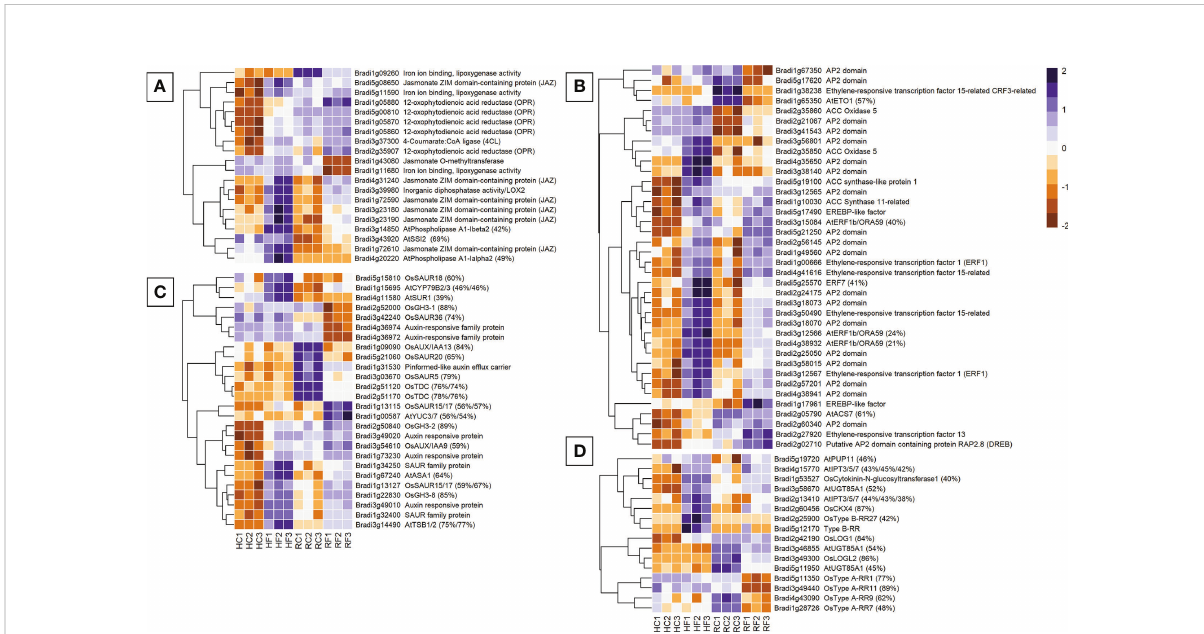
FIGURE 3 The most expressed or repressed phytohormone-associated B. distachyon genes. JA (A) , ethylene (B) , auxin (C) , and cytokinin (D) related genes are displayed. These genes showed a log-fold change of -2 ≤ Log2 ≥ 2 with a p-adj < 0.05 in response to either FHB, FRR, or both. The scale bar on the right is the Z-score for all the heatmaps. Some gene functions have a pre fi x denoting that they were derived from A. thaliana (At) or O. sativa (Os) and they include the percentage of B. distachyon sequence that matches the homologous sequence. Three biological replicates for each of the four treatments are displayed as columns abbreviated as HC (Head-FHB control), HF (Head-FHB fungus), RC (Root-FRR Control), RF (Root-FRR fungus). The control samples (HC1-HC3, RC1-RC3) are normalised transcript counts from mock inoculated head (water with Tween 20) and root (PDA slurry) B. distachyon tissues and were separately analysed through the RNA-seq pipeline with the respective inoculated sample